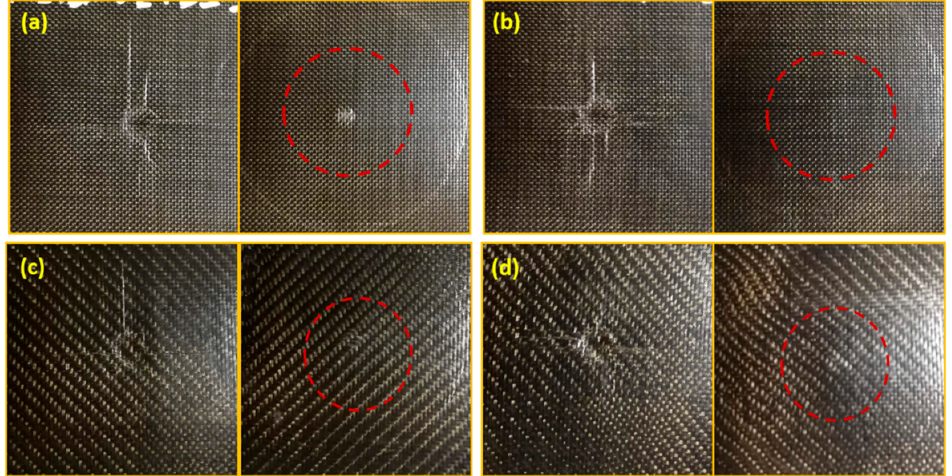
Figure 9. Visual inspections of front (left) and rear (right) surfaces of Plane_TL ( a ), Plane_P40 ( b ), Twill_TL ( c ), and Twill_P40 ( d ) samples; U = 30